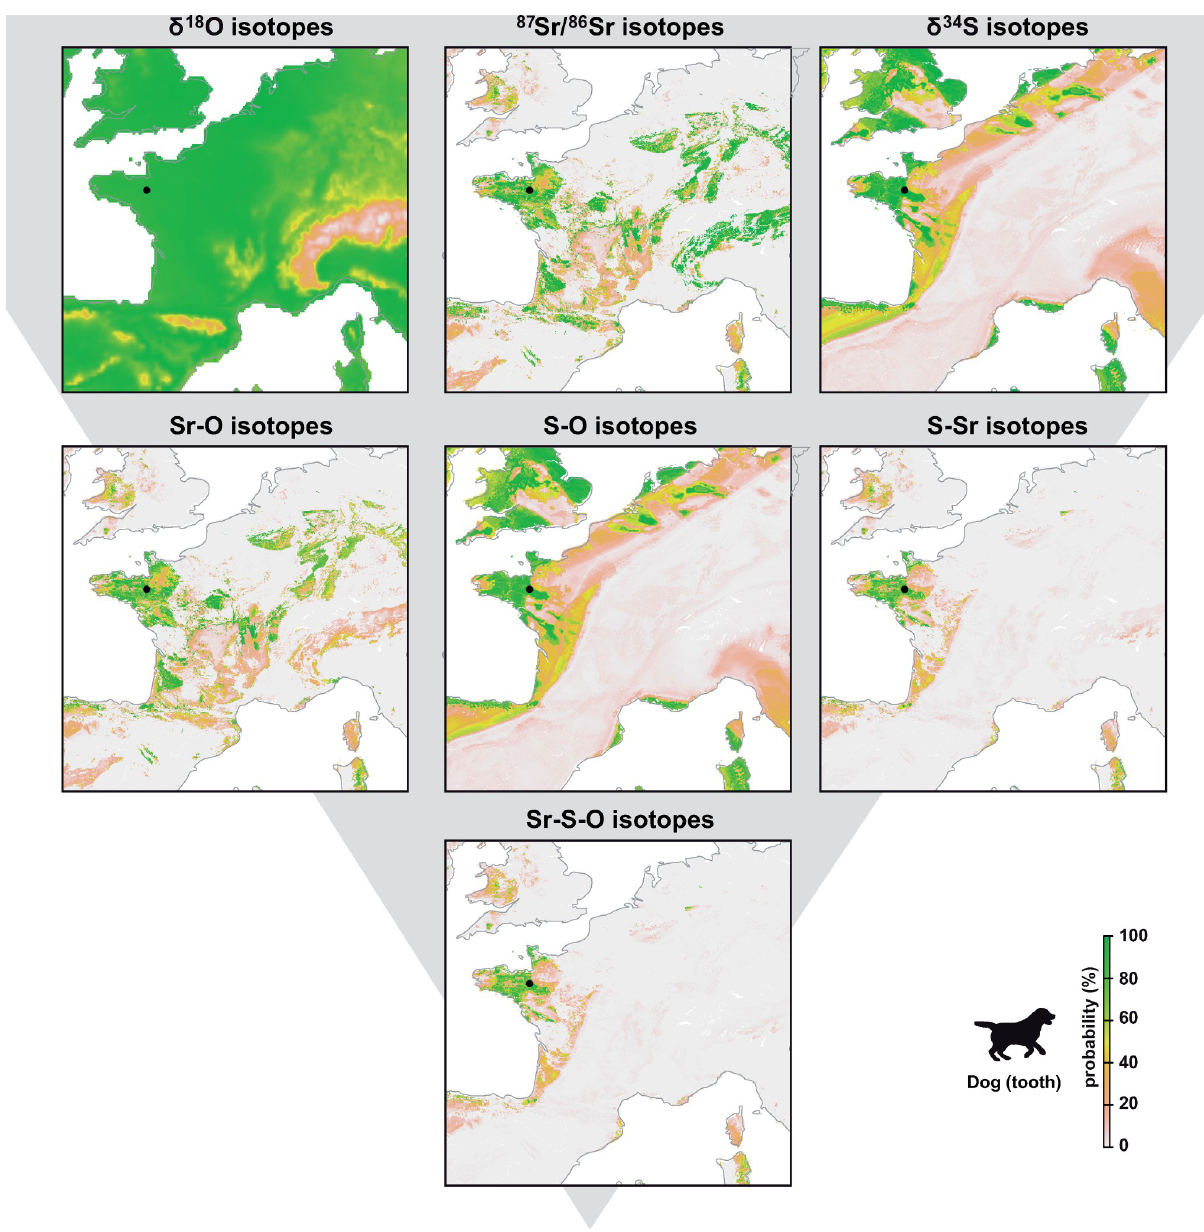
Fig 3. Maps showing the probability of tooth origin of the dog according to the selected isotopes (strontium, sulfur and/or oxygen). Depending on the isotopes and combinations of isotopes used, the geographical area of assignment is increasingly more precise. To generate these figures the script is available in S1 and S2